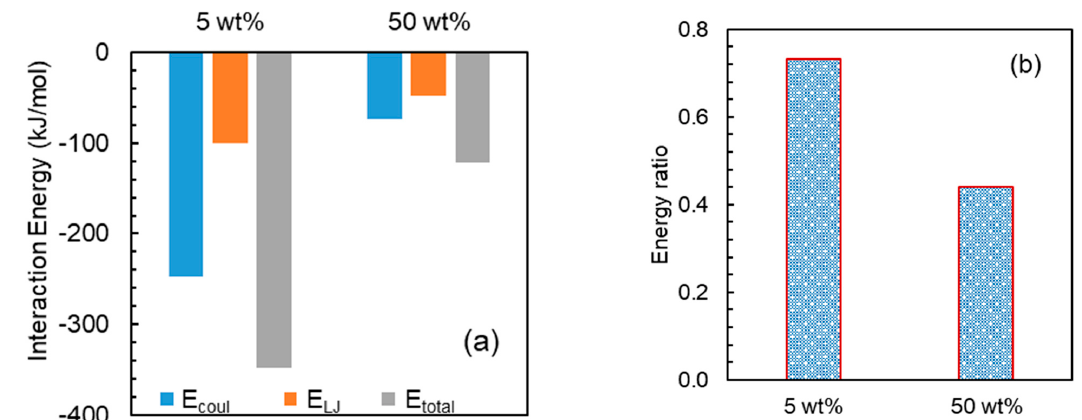
Figure 9. ( a ) Interaction energies between NaDLO and HPMC(P) and ( b ) energy ratio: NaDLO– HPMC(P)/NaDLO–NaDLO at 5 and 50 wt% NaDLO.